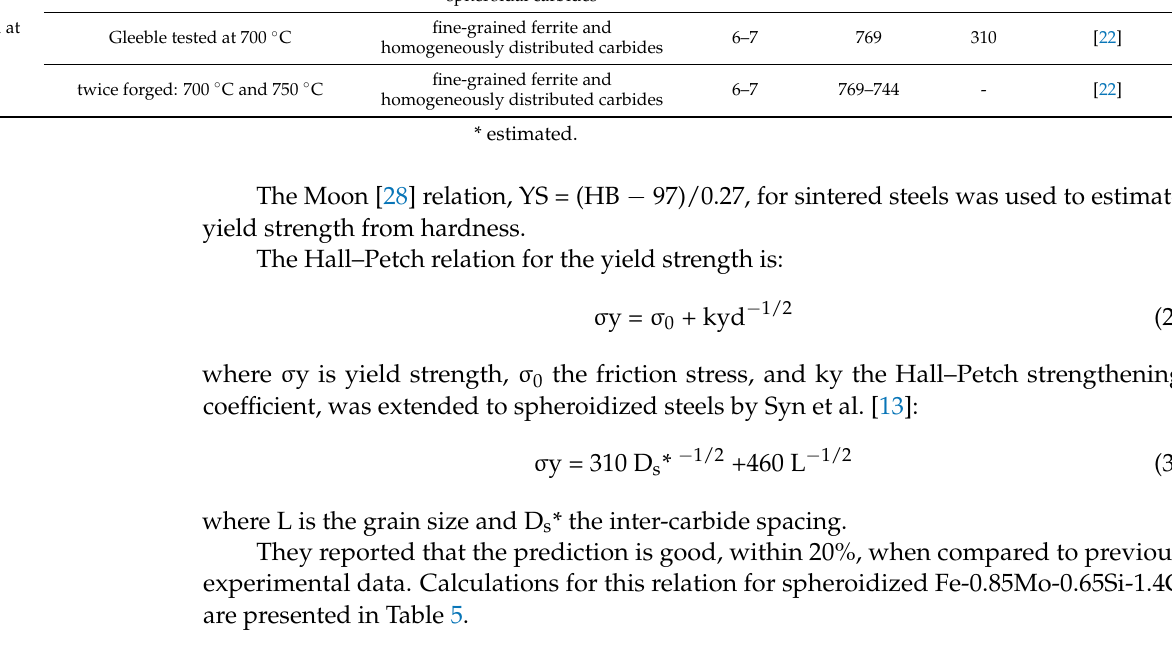
Table 5. Yield strengths of spheroidized Fe-0.85Mo-0.65Si-1.4C measured and according to Syn et al. [13]